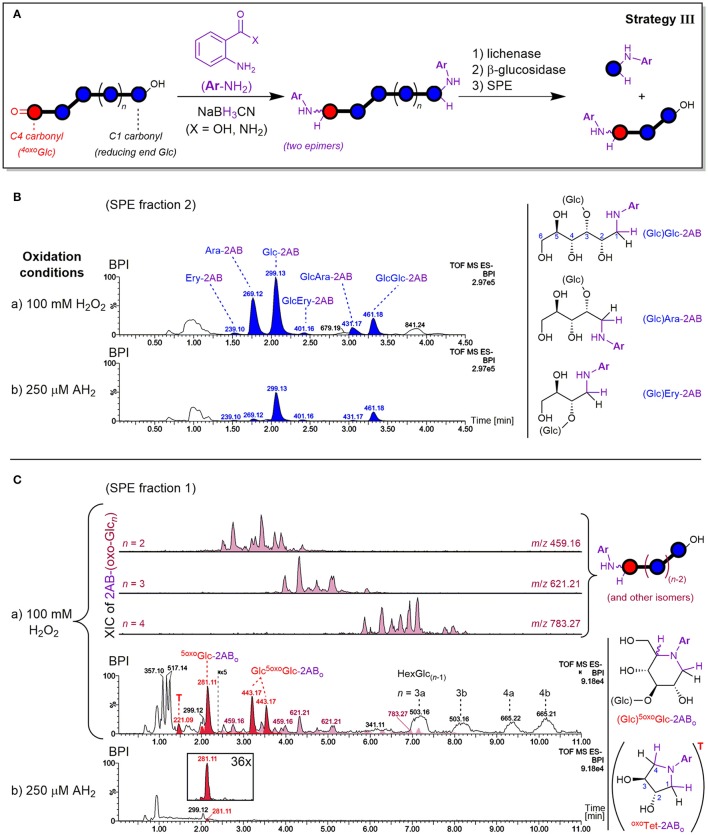
(A) Depiction of carbonyl labeling strategy III by reductive amination with anthranilic acid (2-AA; X = OH) or 2-aminobenzamide (2-AB; X = NH2) with enzyme digestion and SPE steps analogous to strategy II (see Figure 4). Negative mode UPLC-MS base peak chromatograms (BPI; basic eluent) resulting from oxidation of barley β-glucan (BBG) under a) harsh and b) mild conditions after the C=O sample preparation are shown for (B) SPE fraction 2 containing labeled reducing termini, and (C) SPE fraction 1 containing labeled oxo-products with extracted ion chromatograms (XIC) of 2AB-(oxo-Glcn). BPI of (C) were obtained after BPI-subtraction of the control sample (0.6% BBG) subjected to the same sample preparation, and the insert under b) shows the 36x zoomed XIC of m/z 281. AH2, ascorbic acid; Glc, glucose; Ara, arabinose; Ery, erythrose; Ar, aromatic ring; 5oxoGlc-2ABo, presumed cyclic product from 5-oxo-reducing ends (see Figure 8); oxoTet-2ABo = “T,” presumed cyclic product of l-threo-tetrodialdose (m/z 221); 2AB-(oxo-Glcn), labeled oxo-Glcn at oxidized C=O group; HexGlc(n−1), oligosaccharide with one sugar unit being an undefined hexose (side products, presumably from direct reduction of oxo-Glcn; see Figure S9).